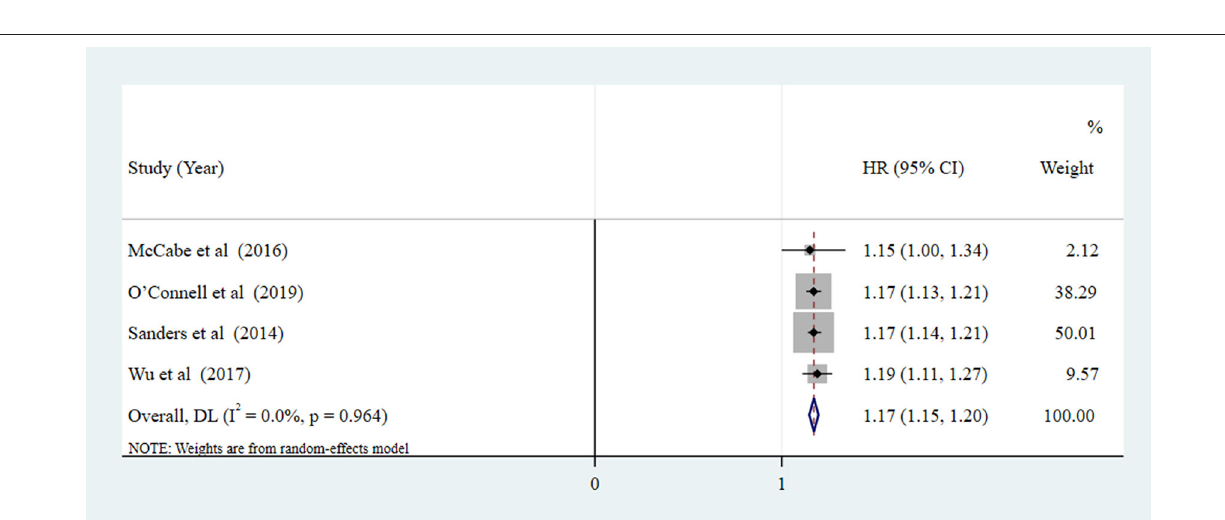
FIGURE 3 | Forest plot of the pooled HR of all-cause mortality risk for SA (SA as a continuous variable, measured by HAI: The scores for each component were arranged into least healthy group (two points), middle group (one point), and most healthy group (zero points). The component scores were summed to create the HAI, ranging from 0 [healthiest] to 10